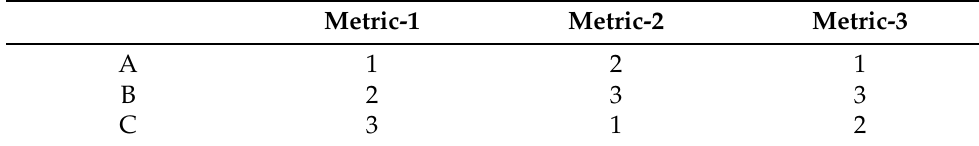
Table 4. An example of a simulated class